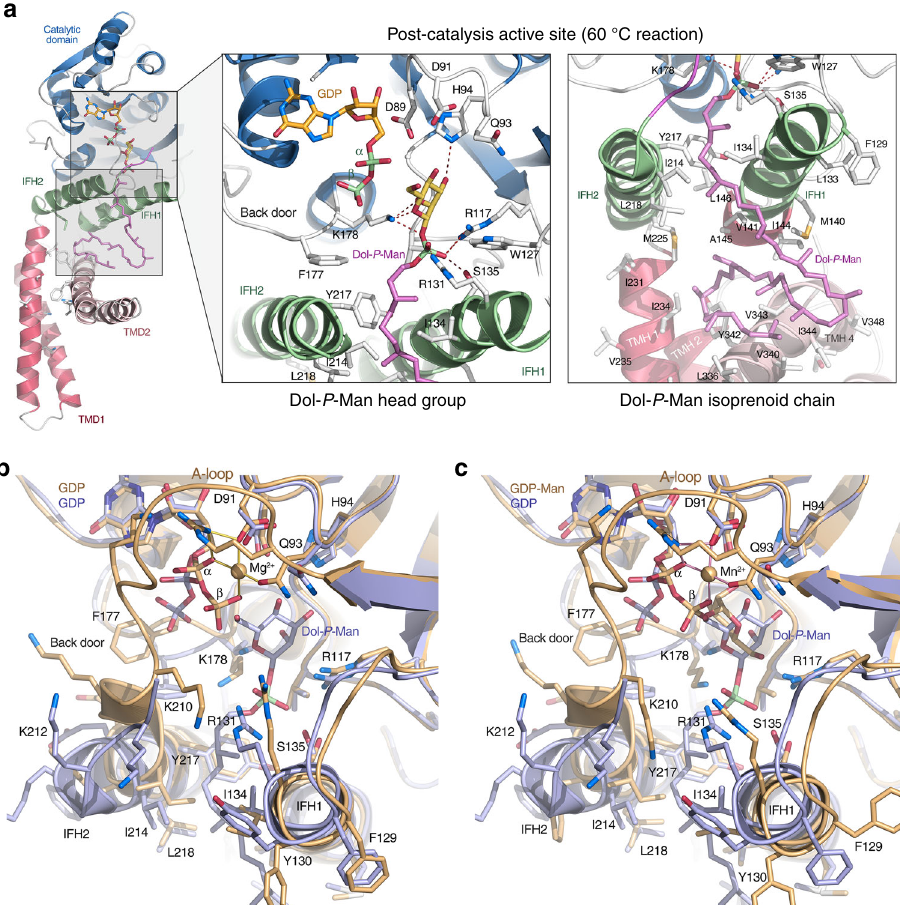
Fig. 3 Structure of the Pf DPMS • GDP • Dol55- P -Man complex. a Enlarged views of the active site ( left inset) and the TM domain ( right inset). Left inset, the Dol- P -Man head group is shown bound in the active site of wild-type Pf DPMS. The metal ion has departed and the GDP diphosphate group has fl ipped away from the transfer site towards the “ back door ” , to accommodate the glycolipid product. Right inset, the Dol- P -Man isoprenoid chain traces down to the TM domain where it rests on TMH4. The acceptor loop is open and Phe177 is in the “ down ” position. Superimposition of the crystal complexes b Relevant side chains are